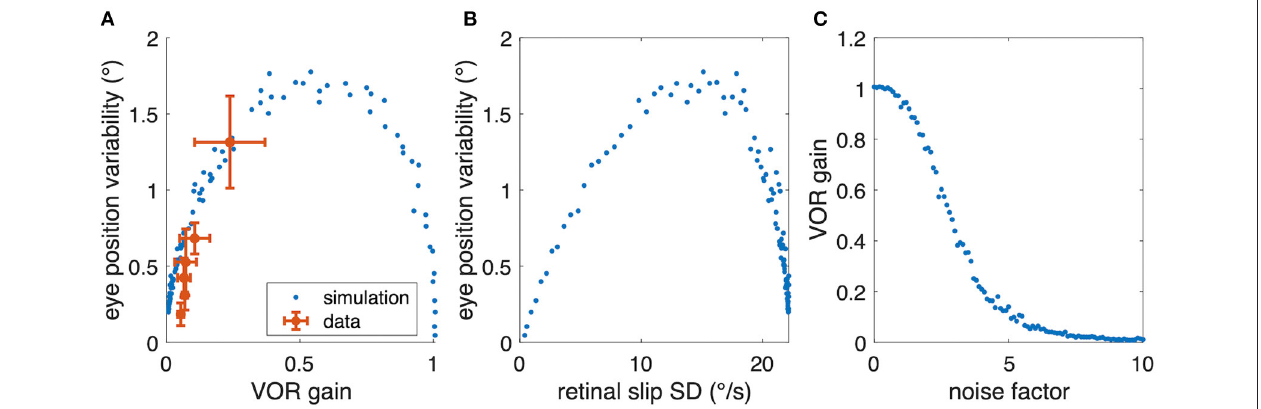
FIGURE 7 | Relation between aVOR gain and variability of eye movements. (A) Replot of data from Figure 6C (red) together with model simulations of the standard aVOR model with varying sensorimotor noise and optimized aVOR gain (all other model parameters kept constant); the model predicts that for low aVOR gain values, the eye position variability will increase with increasing gain values ( < 0.5), but decrease again for higher values ( > 0.5). (B) Variability of eye movements for each animal plotted with respect to the retinal image slip [same simulations as in (B) ]. (C) Optimal aVOR gain values [model simulations as in (A,B) ] decreases with the sensorimotor noise